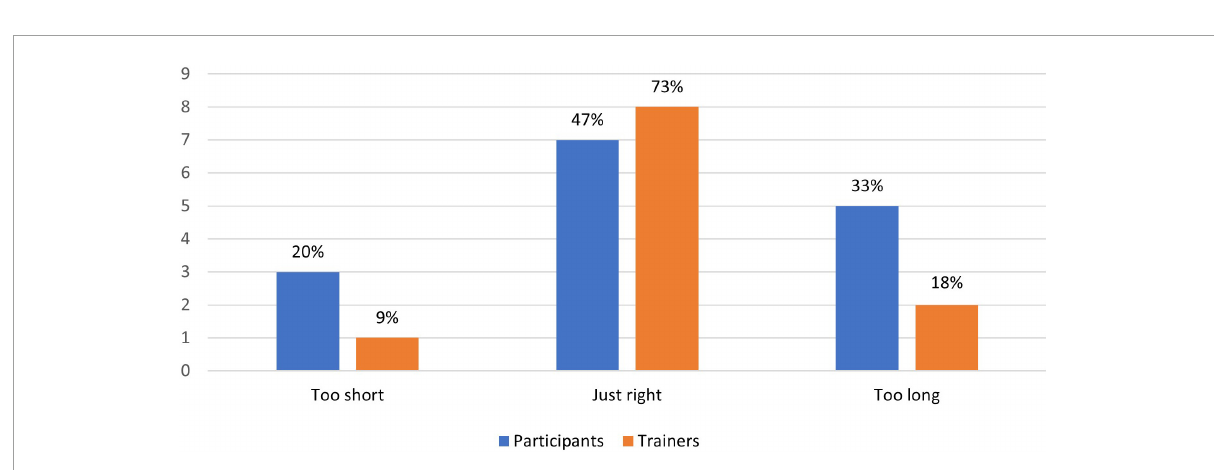
FIGURE8 Feedback on the duration of the Augmented Reality Games to Enhance Vocational Ability of Patients (REAP)